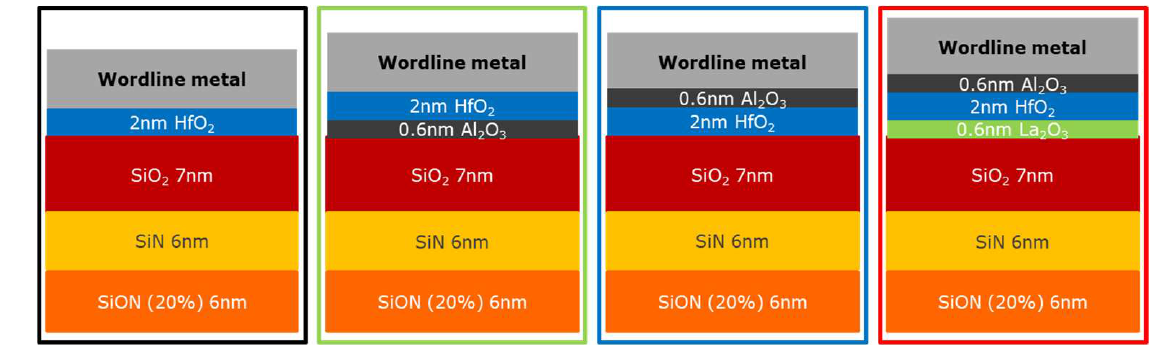
Figure 15. Schematic of MHONOS stacks with dipole-forming interlayers at different locations. Al 2 O 3 and La 2 O 3 , each 0.6 nm thin, were used as interlayers with HfO 2 used for high-k value.